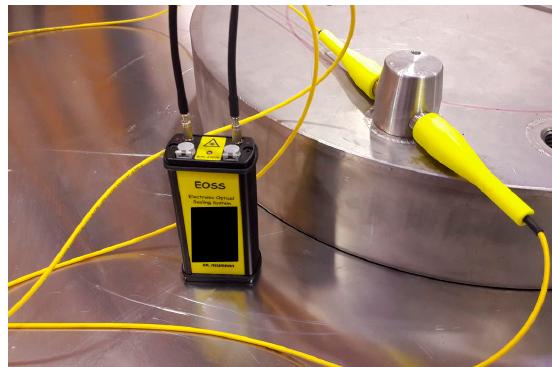
Figure 6. Picture of the EOSS seal connected to the UOSB seal.